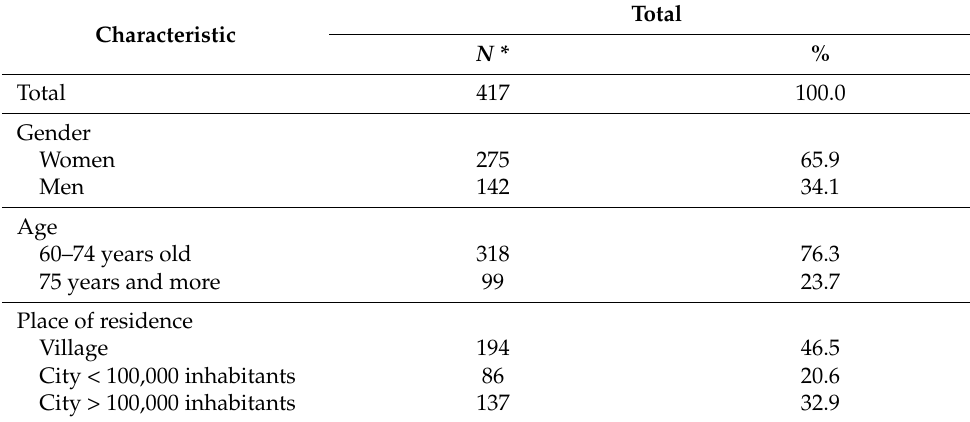
Table 2. Characteristics of the study